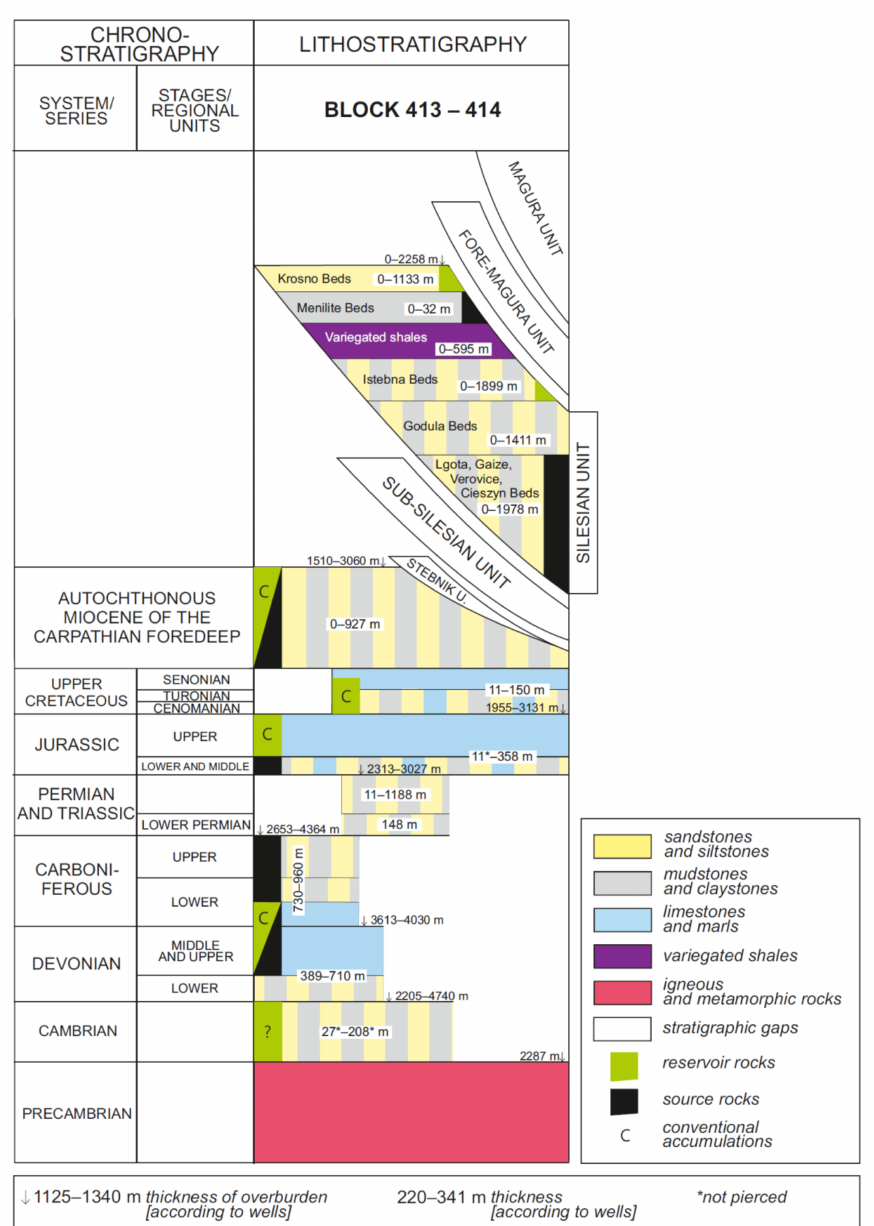
Figure 7. Stratigraphy, lithology, and petroleum system elements (horizons of source and reservoir rocks) in the Block 413–414 tender area dedicated to the 6th tender round for hydrocarbon concessions in